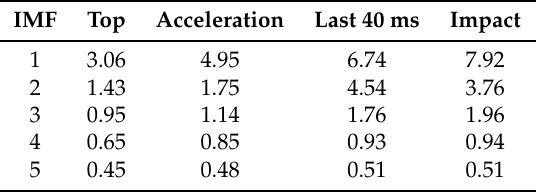
Table 7. Right hand joint rotational instantaneous frequency (Hz) of golf